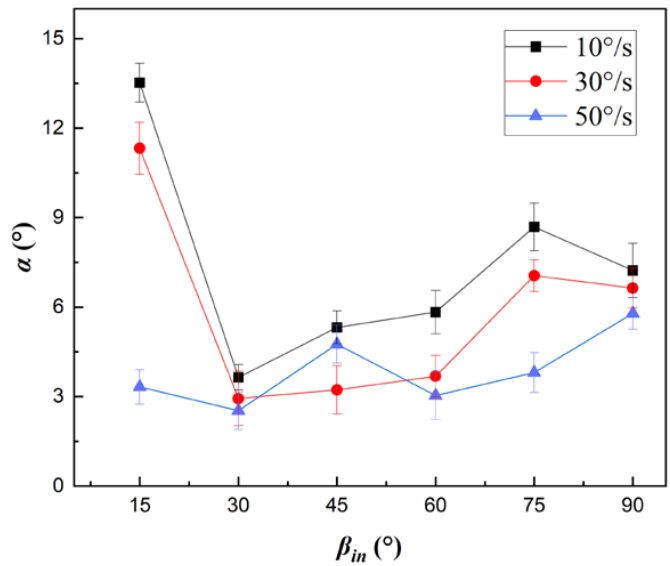
Figure 3. Effect of rotational speed on deflection angle α.